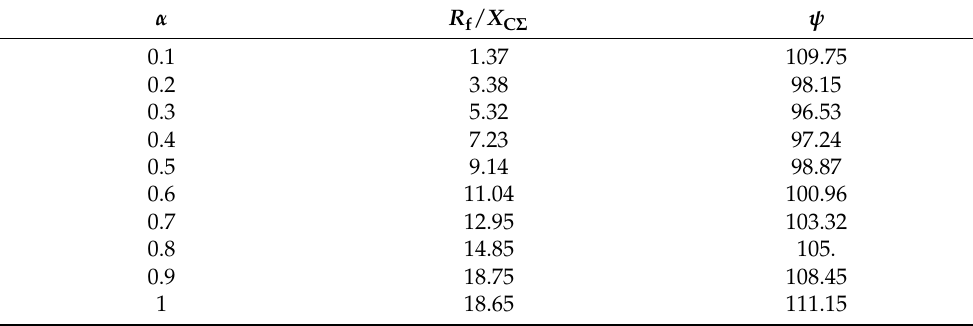
Table 1. Angle values at different fault